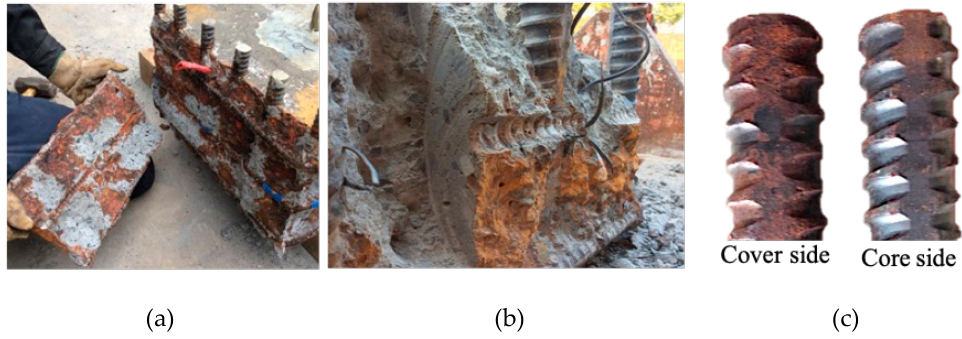
Figure 8. ( a ) Representative internal crack surfaces ( b ) corrosion product migration and ( c ) surface condition of the longitudinal bar after accelerated corrosion testing. condition of the longitudinal bar after accelerated corrosion